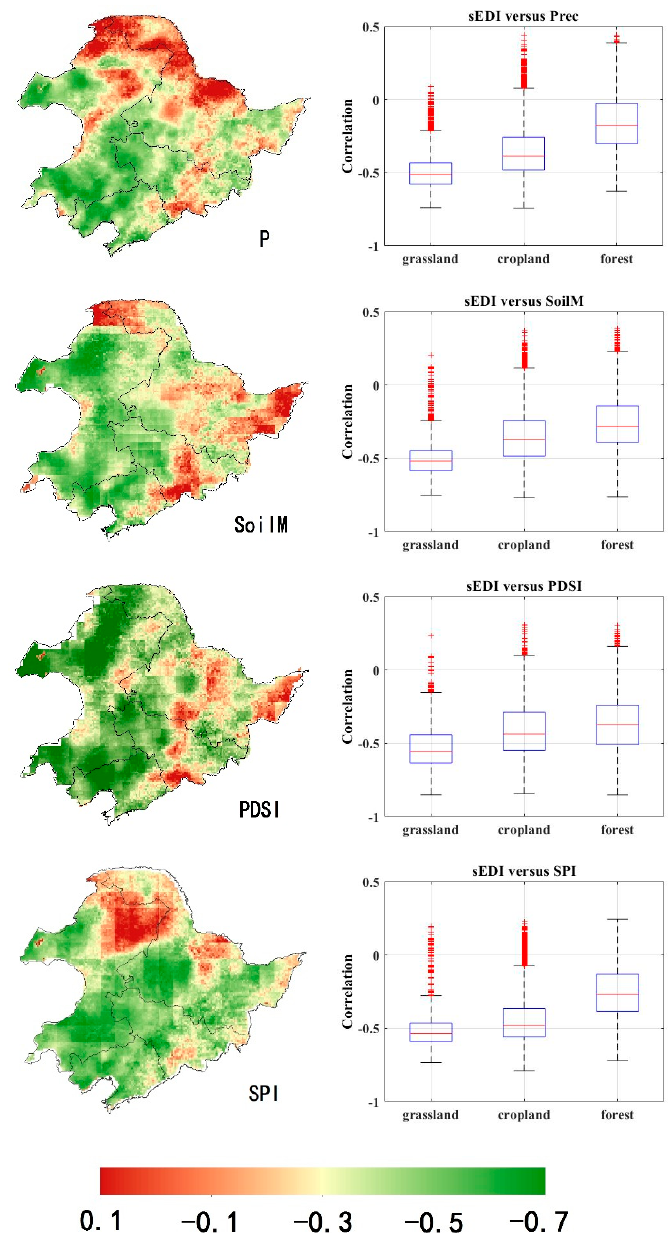
Figure 10. (Left) Coefficient of temporal correlation between annual maps of Standardized Evaporative Drought Index (sEDI) and other drought indices for 1982–2012. Green indicates strong negative correlation and red indicates weak correlation. (Right) Coefficient of temporal correlation between annual maps of sEDI and other drought indices for three main landscapes: grassland, cropland, and forest. Boxplot depicts median, 25% to 75% range (box) and 10% to 90% range (whiskers). Further investigation illustrates the correlation computed between sEDI and selected index at pixel levels (Figure 11). In comparison with SPI, PDSI has relatively better correlations with sEDI anomalies, which highlights the importance of other influencing factors like temperature and soil moisture. On the other hand, the highest correlations between sEDI and PDSI were obtained in 2007, when there was a severe drought at the end of this year. Similarly, indices also show strong correlations in 2004, 2006, and 2010, which indicates the spatial patterns of sEDI closely resemble other indices during a relatively dry